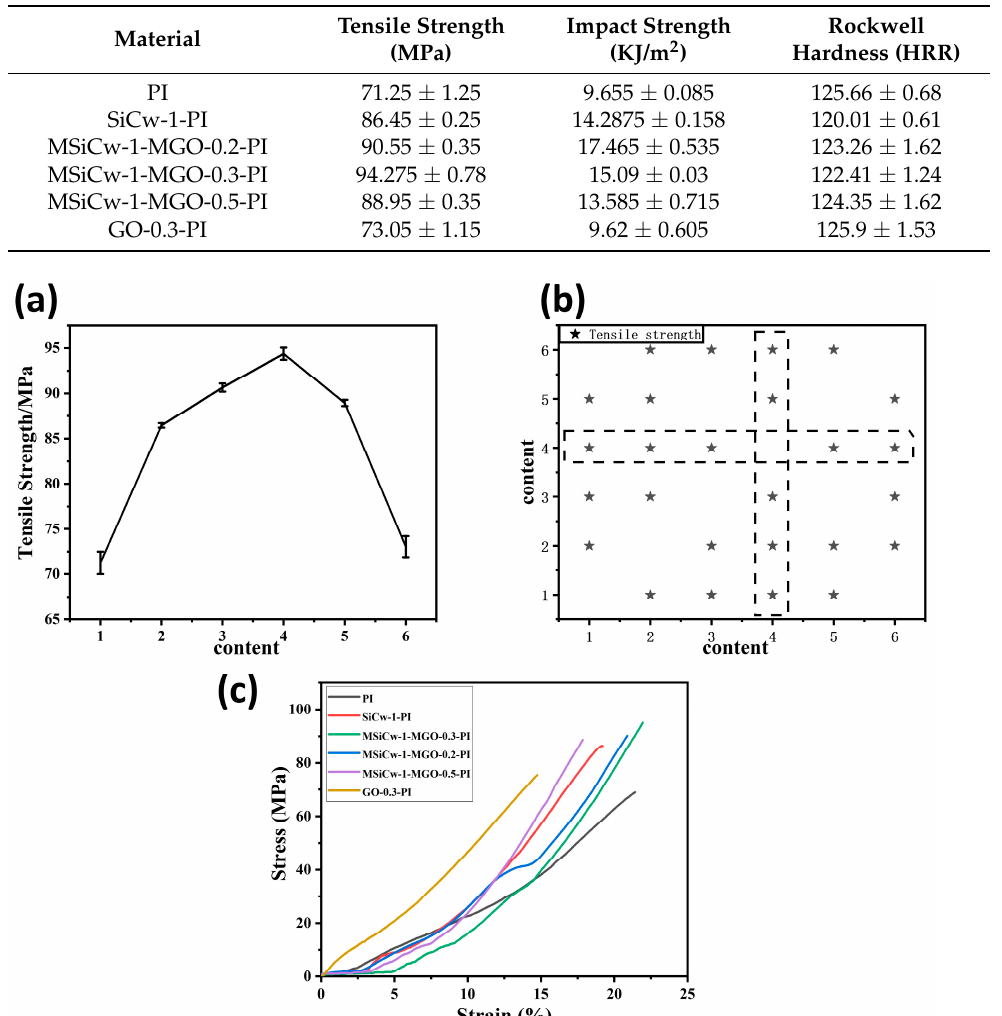
Table 1. Mechanical Properties of PI and composites with various reinforcing phases content.